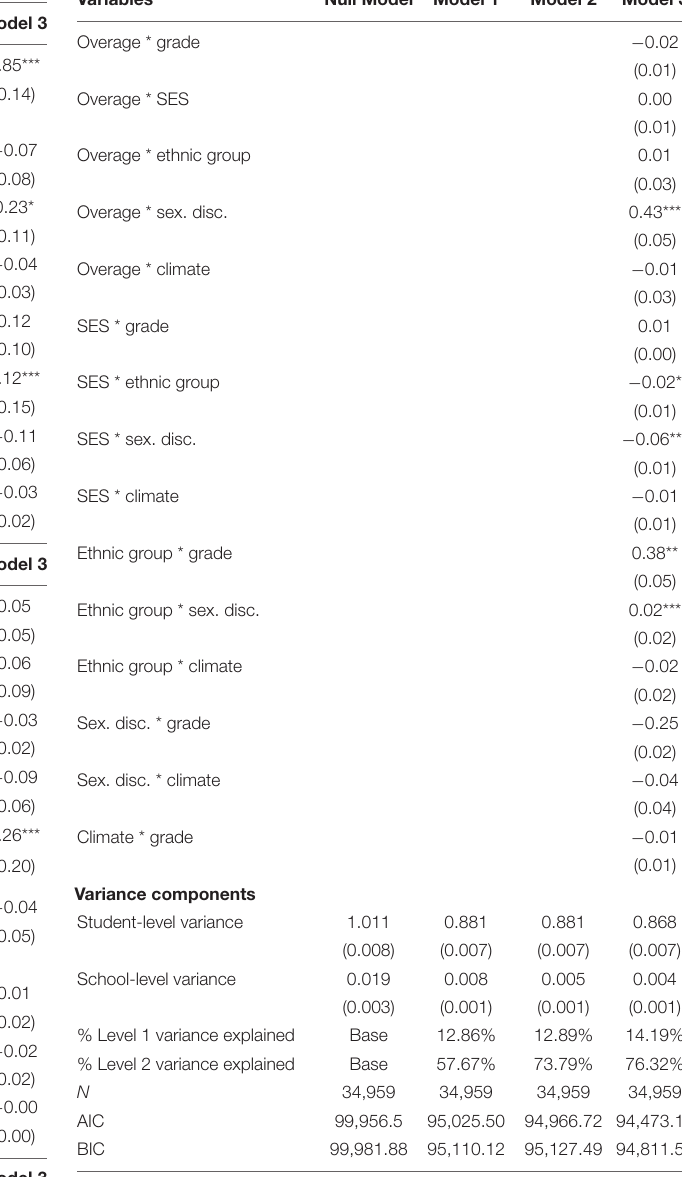
TABLE 3 | Multilevel model results predicting peer cybervictimization from individual and school level variables using full maximum likelihood